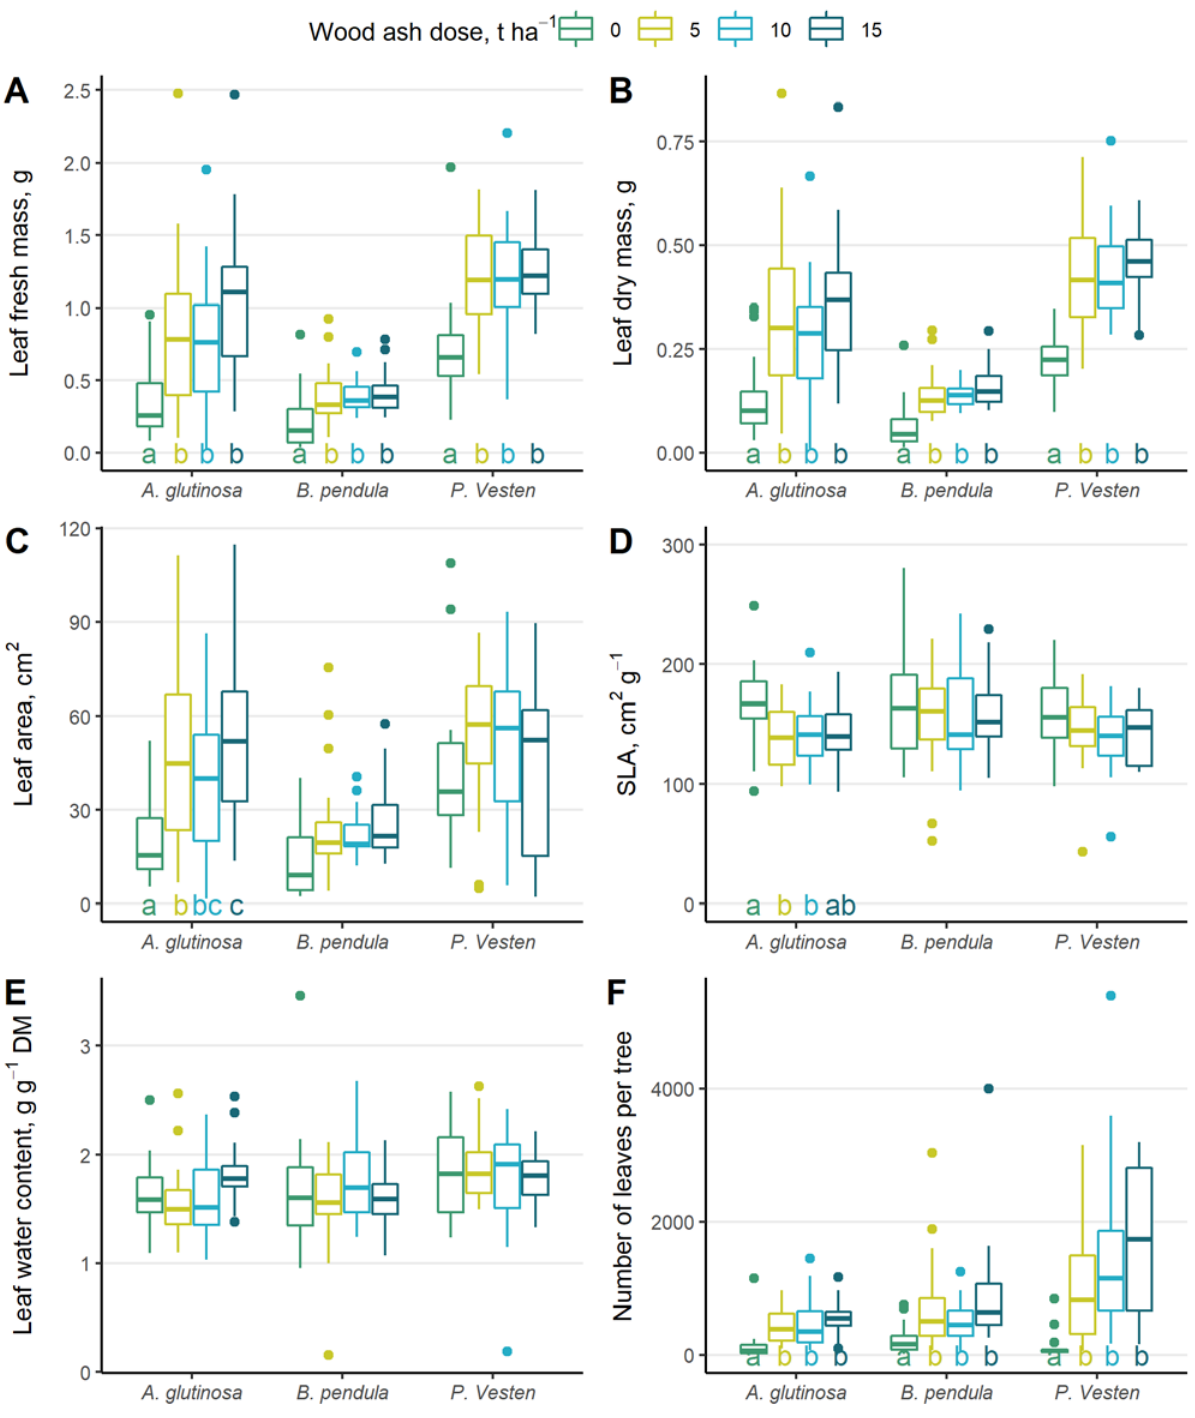
Figure 3. Studied tree species traits. (A) leaf fresh mass (B) leaf dry mass (C) leaf area (D) SLA (specific leaf area) (E) leaf water content per dry mass (F) number of leaves per tree . Letters denote significant (p adj . < 0.05) differences between fertiliser dose for each